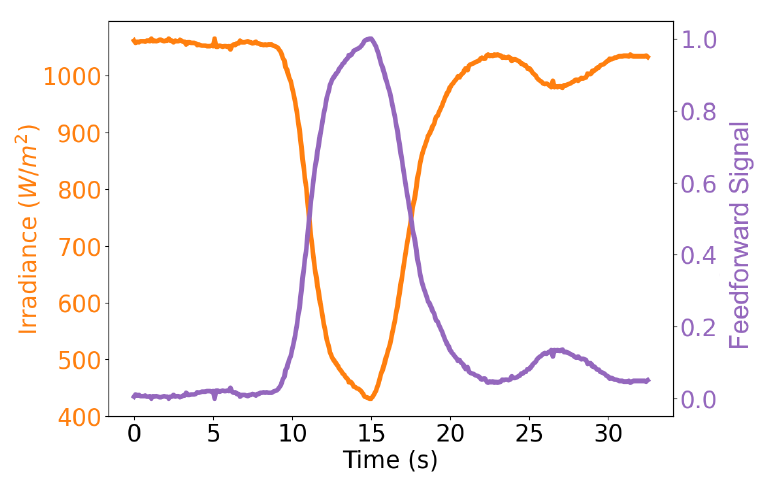
Figure 7. Feedforward signal, equivalent to the normalized and inverted irradiance, used to simulate the system voltage drop corresponding to Cloud 2.